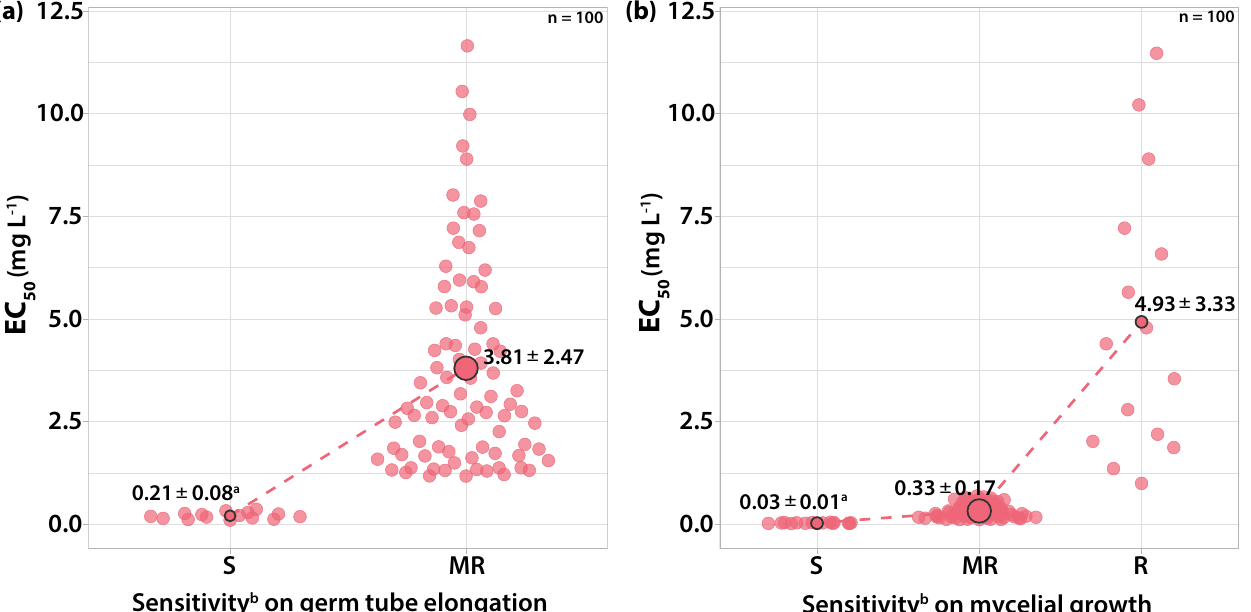
Figure 5. Frequency of sensitivity distribution for one hundred V. inaequalis isolates to difenoconazole on ( a ) germ tube elongation and ( b ) mycelial growth. The mycelial growth stage was found to be more sensitive than the germ tube elongation during the bioassays with difenoconazole. Since the DMI fungicides primarily affect the mycelial growth of the fungi, the concentrations of 0.1 and 1 mg L − 1 were used to discriminate the sensitivity levels on point inoculation assays. The mean EC 50 values for the moderately resistant or resistant population of V. inaequalis were significantly higher ( p < 0.05) than the mean EC 50 values of the sensitive population on both tests according to the Welch’s t -test. a Average values of sensitivity groups ± standard deviation; circle size reflects the population number. b Sensitivity groups: S, sensitive; MR, moderately resistant; R,